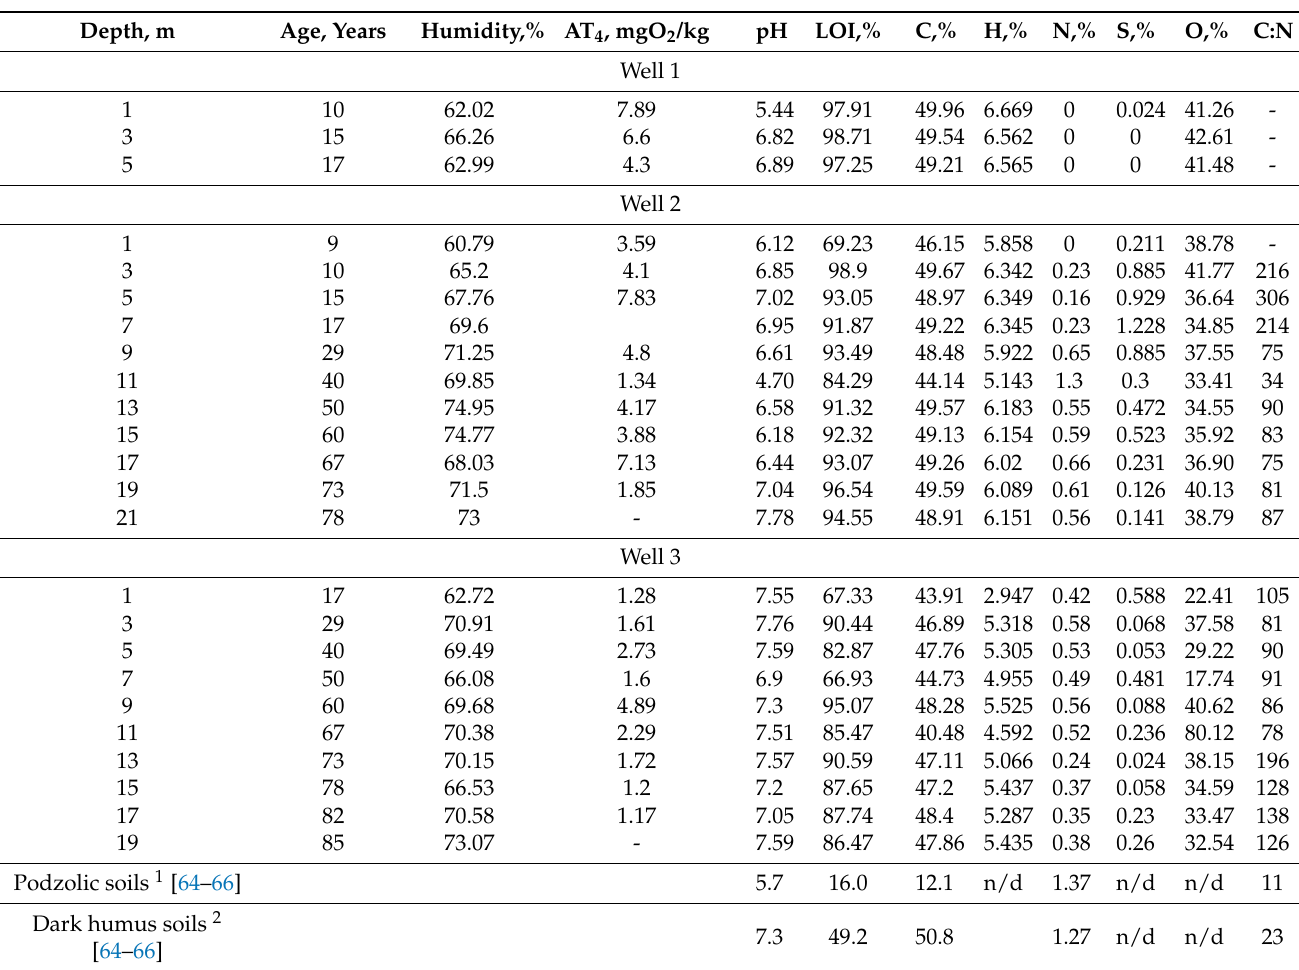
Table 2. Results of the physicochemical analysis of BWW